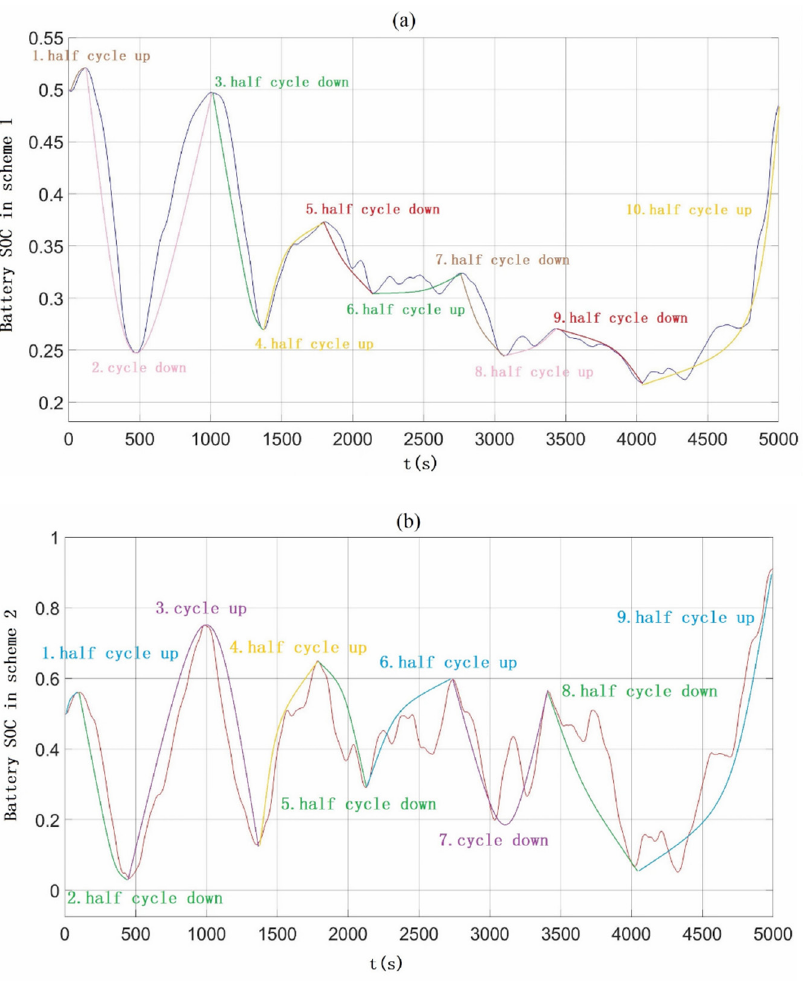
Figure 20. ( a ) Cycle counting of the DOD of LiBs in scheme 1. ( b ) Cycle counting of the DOD of LiBs in scheme 2. Table 3. Battery lifetime prediction